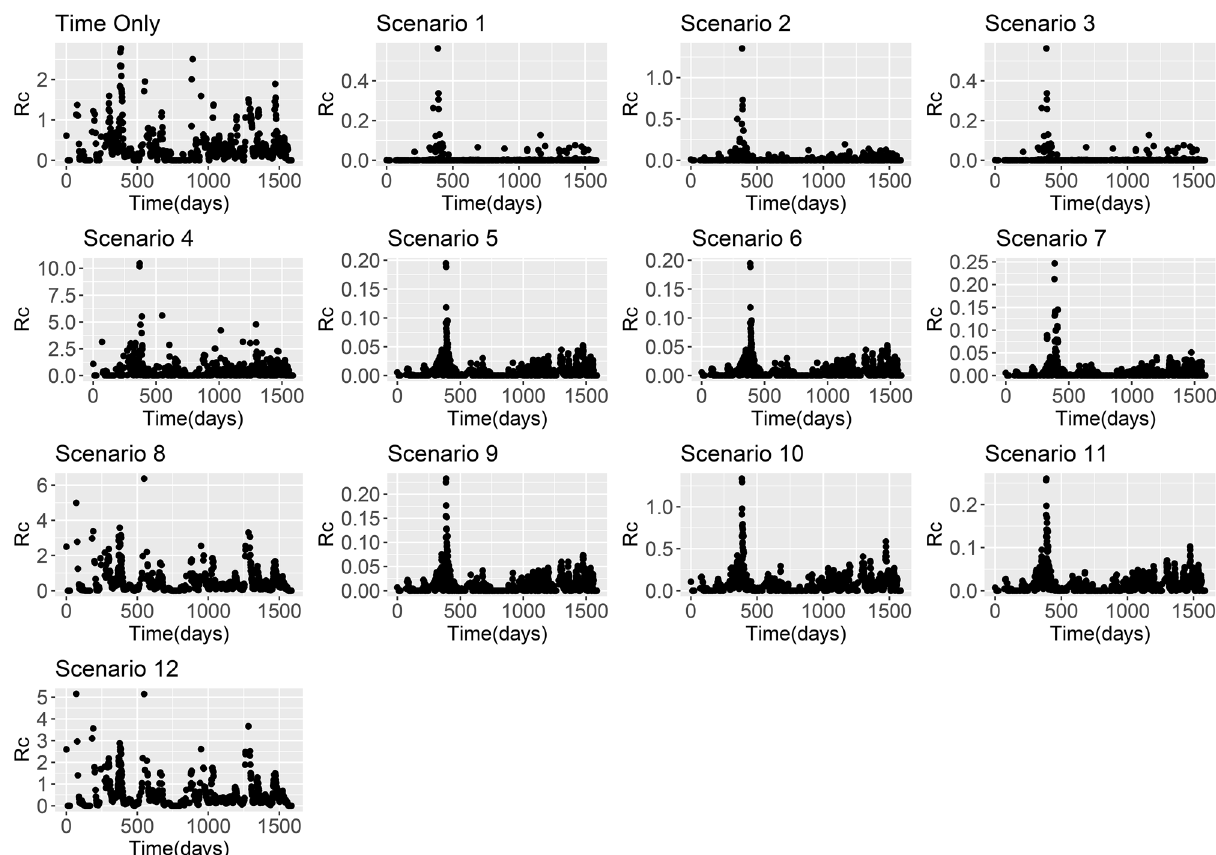
Figure 2. R c estimates from Eswatini line list based on using the time-only scenario and Scenarios 1–12 with an exponential